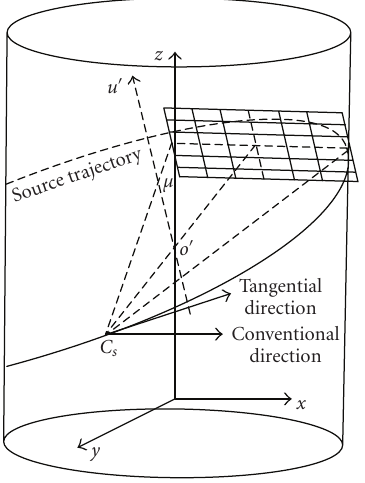
Figure 2: Illustration of conventional filter direction and tangential filter